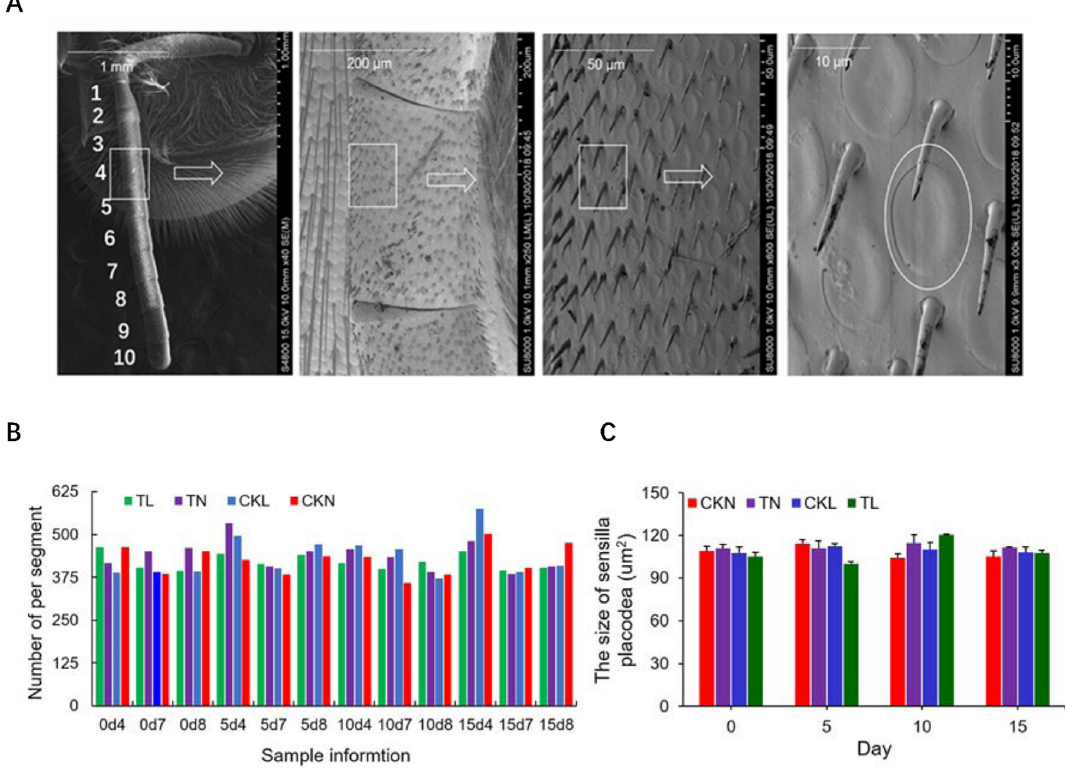
Fig 7. Flagellum of the honey bee antenna observed with scanning electron microscopy (SEM). A. SEM of antennal segments of scape for worker showing antenna and olfactory sensillum B. The number of sensilla placodea on 4, 7, 8 segments in the right antennae of infested and non-infested bees at 0, 5, 10 and 15 days. C. The size of sensilla placodea in the right antennae of infested and non-infested bees 0, 5, 10 and 15 days. For the actual measurement was performed in duplicate (i.e. two biological replicates, A and B) alongside